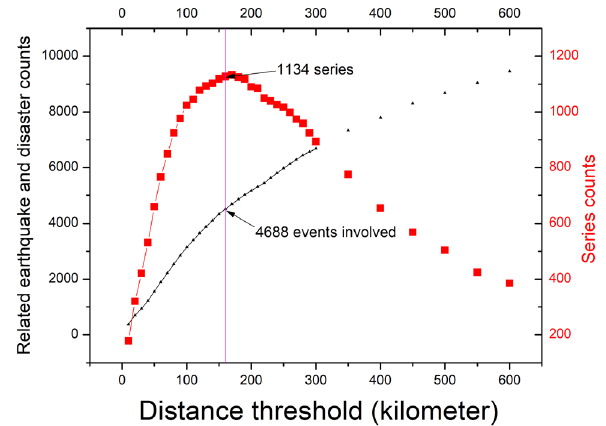
Fig. 12 The maximum area of series compared with the earthquake counts